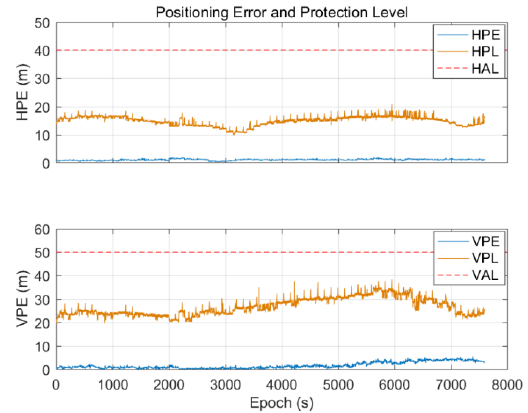
Figure 11. The VPE histogram of flight test-I. The green line in the figure is the vertical accuracy (95%), which is 4.38 m.